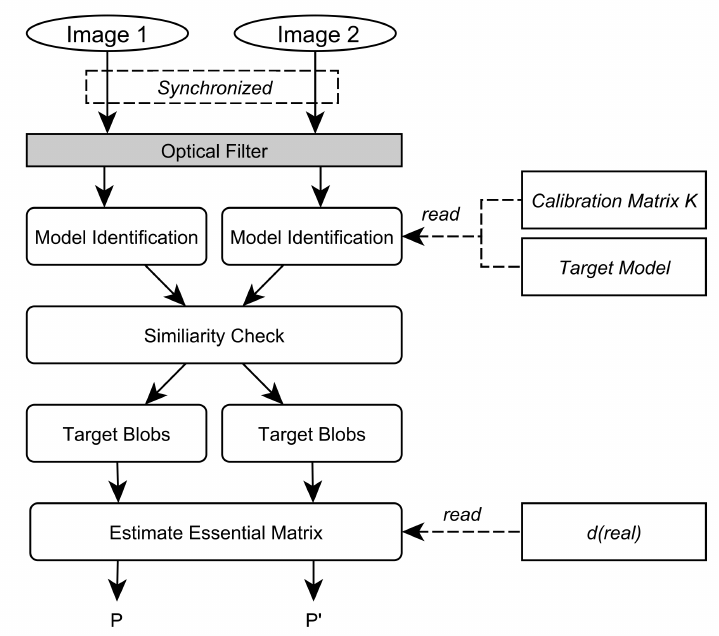
Figure 6. Extrinsic calibration